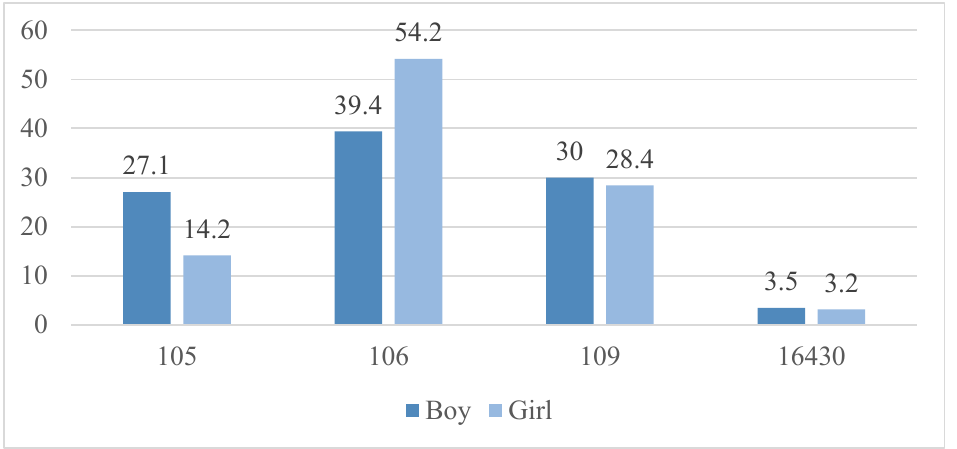
F IGURE 1. P ERCENTAGE DISTRIBUTION OF THE KNOWLEDGE LEVEL OF RESPONDENTS